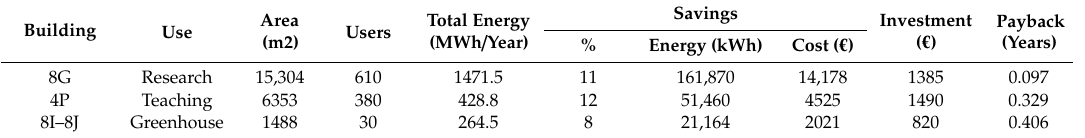
Table 3. Summary of annual results in the analysed buildings after